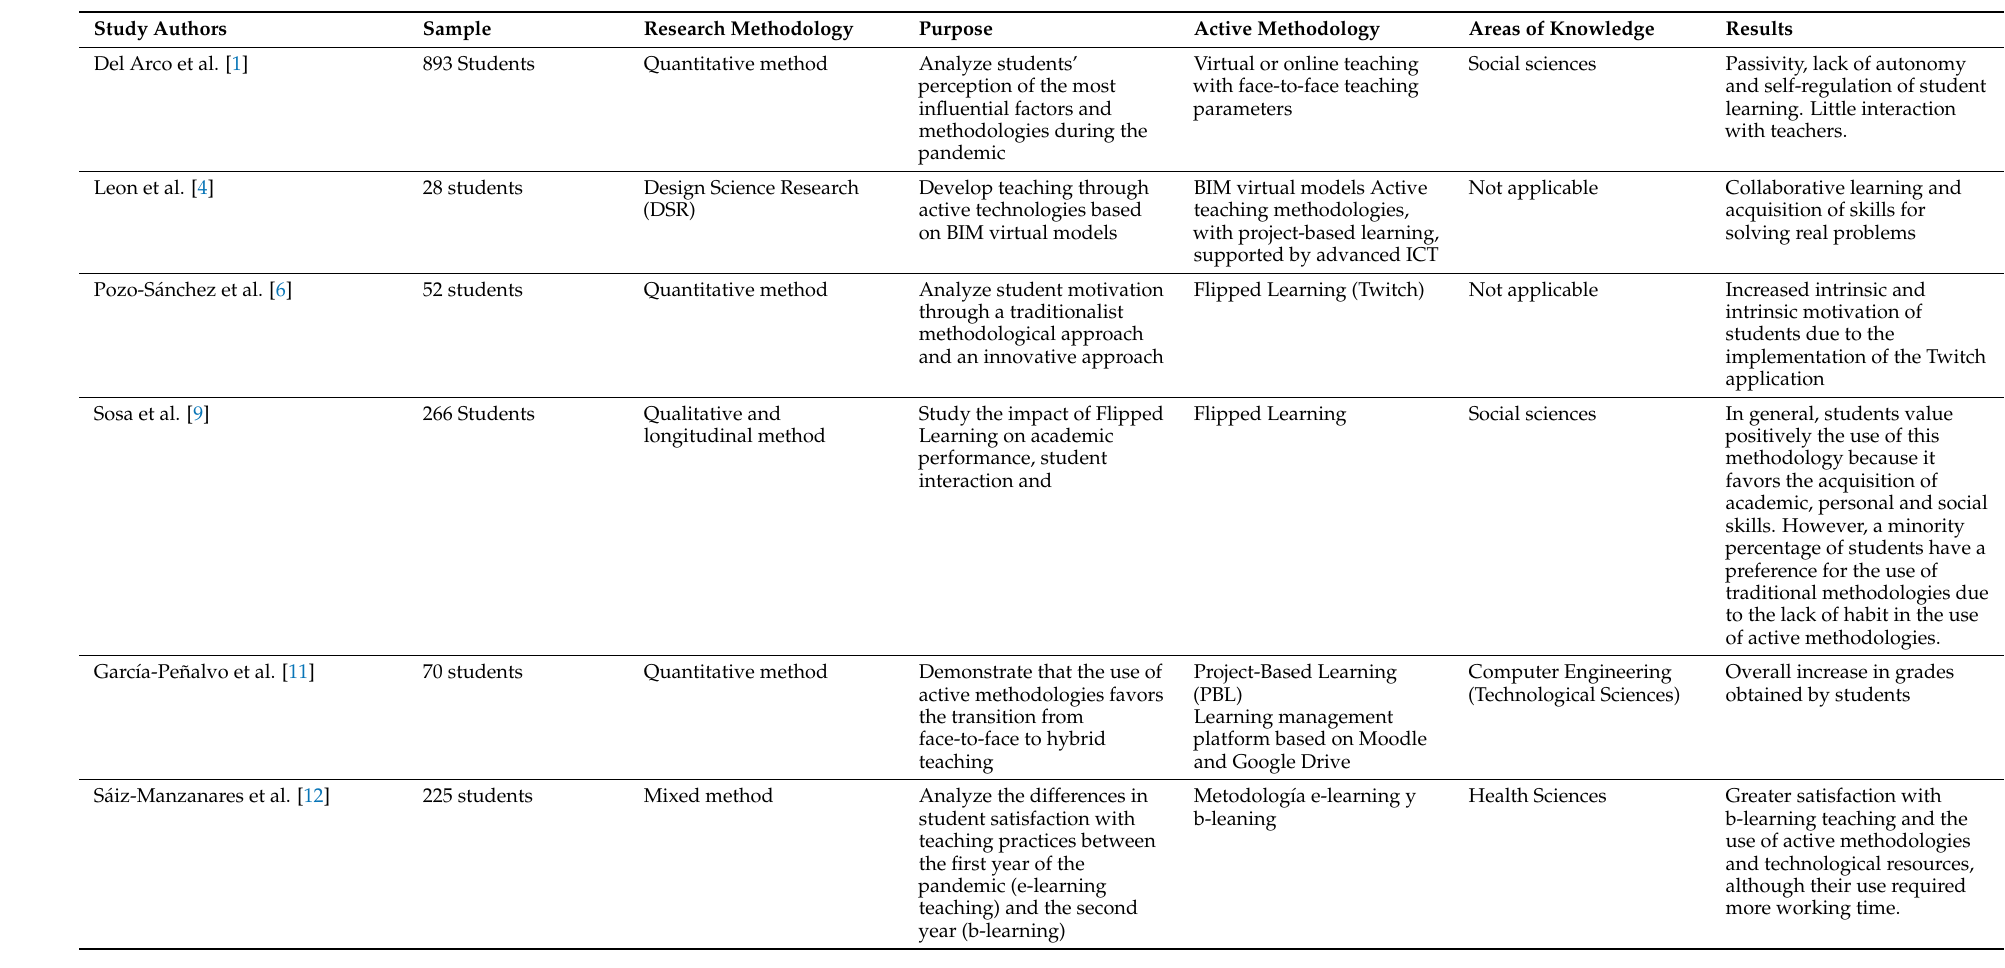
Table 3. Main characteristics of the selected